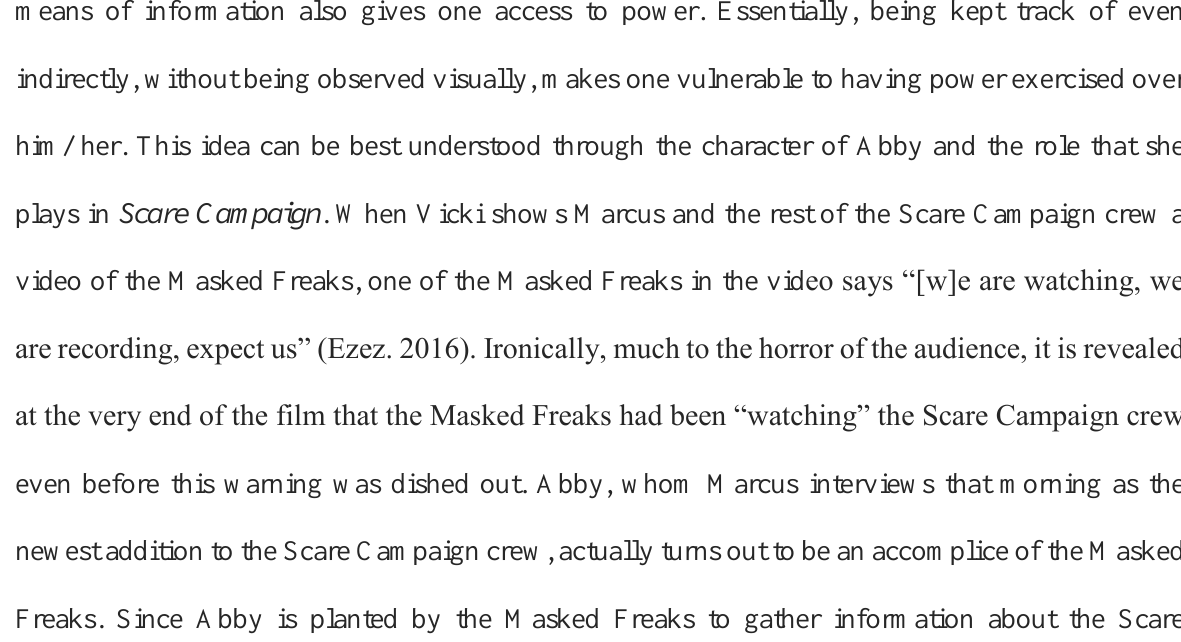
CINEJ Cinema Journal: Panoptic Pranksters: Power, Space and Visibility in the Information Panopticon in Scare